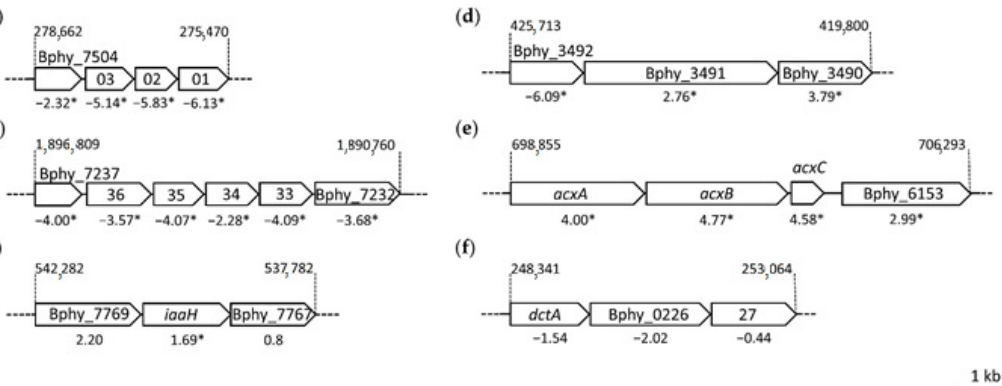
Figure 3. A selection of P. phymatum operons showing differential expression in nifA nodules compared to wild-type nodules. The following operons are represented: ( a ) lysine/arginine/ornithine ABC transporter; ( b ) alkane sulfonate ABC transporter; ( c ) indole-3-acetic acid synthesis ( iaa ); ( d ) efflux RND transporter; ( e ) acetone carboxylase ( acx ); ( f ) dicarboxylate symporter ( dct ). The genomic coordinates according to the replicon where the operon belongs are indicated at the beginning of the operon and gene names are indicated in italic. The log 2 FC values are shown underneath the operons, with statistically significant ones marked with an